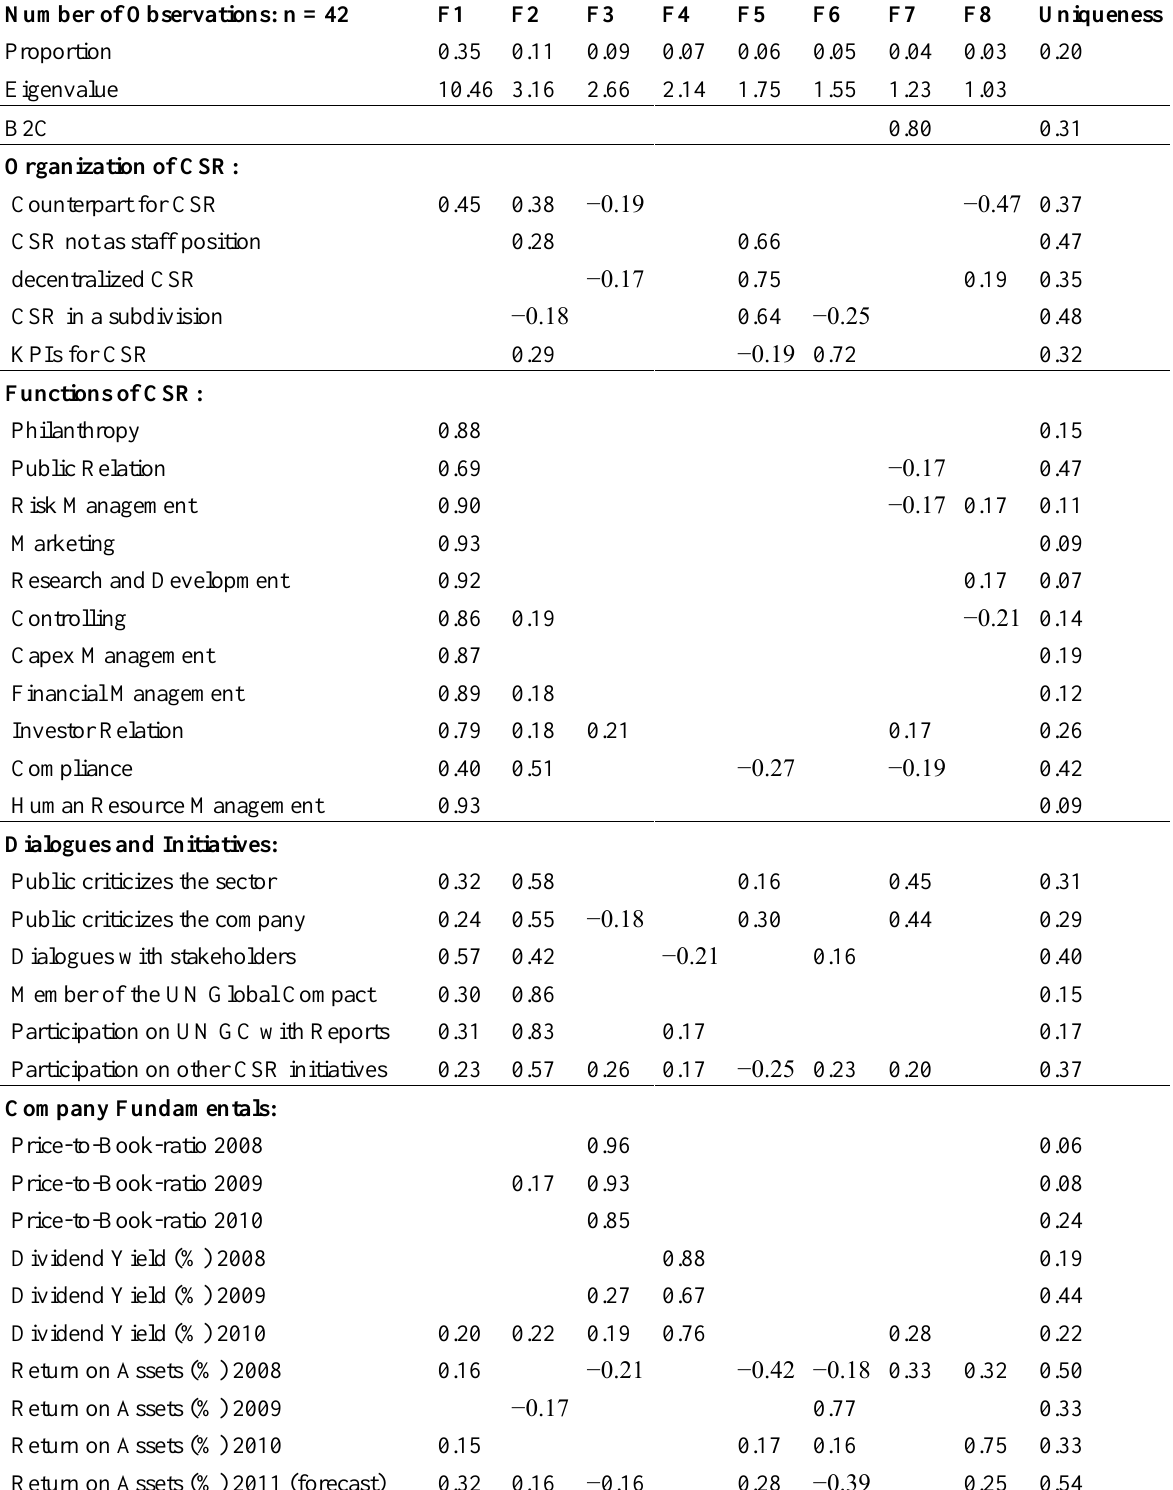
Table 1. Results of the empirical study: factor